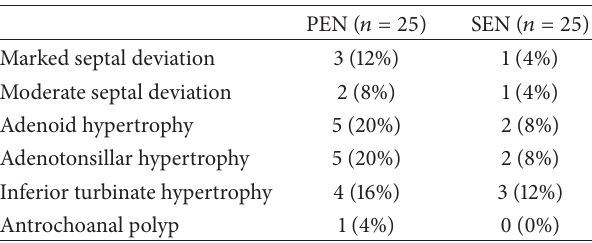
Table 1: Otorhinolaryngologic examination of PEN and SEN